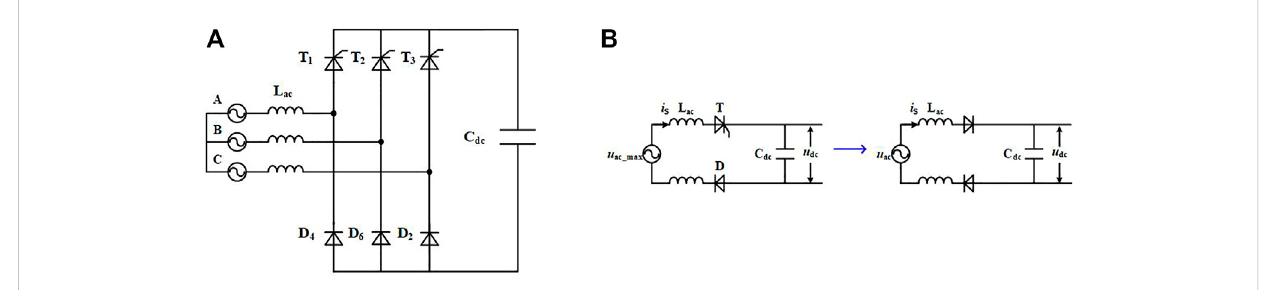
FIGURE 3 Equivalent circuit of the improved VSC in SCR control phase. (A) Equivalent circuit and (B) simpli fi ed equivalent circuit.